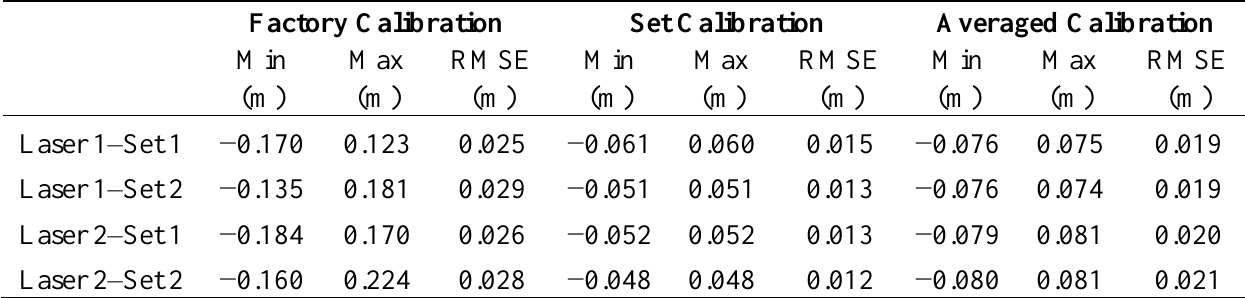
Table 4. Planar Misclosures for Each Observation Set with Factory, Set and Averaged Calibration